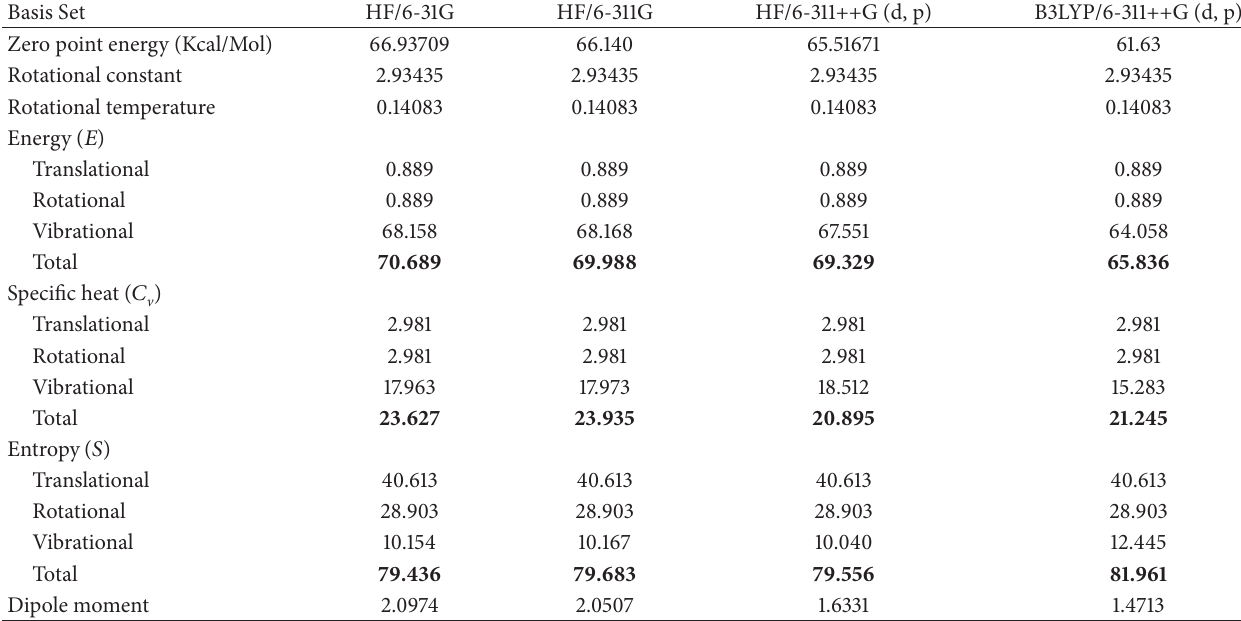
Table 7: The calculated thermodynamical parameter of